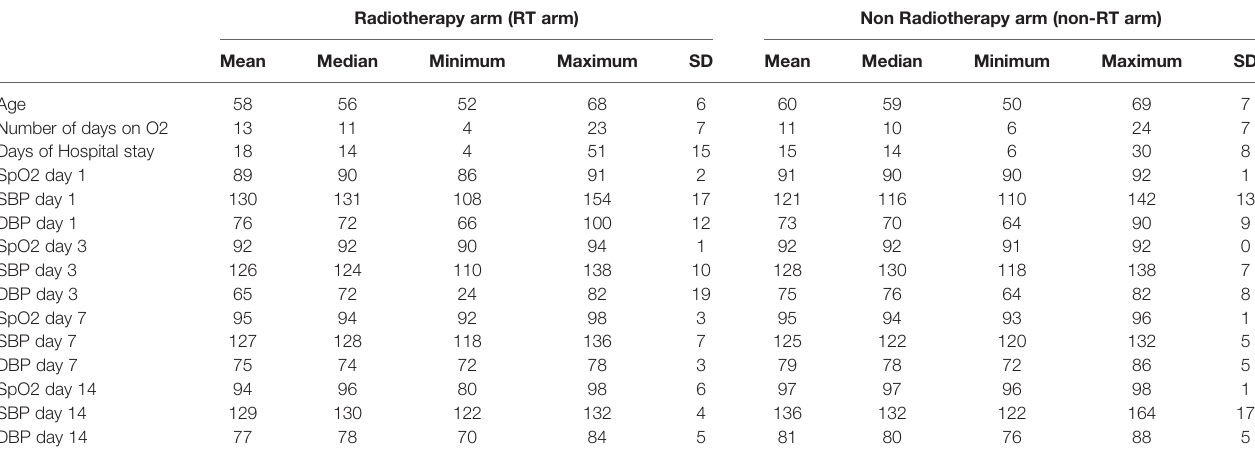
TABLE 2 | Clinical parameters of patients on the day of LDRT and serial follow